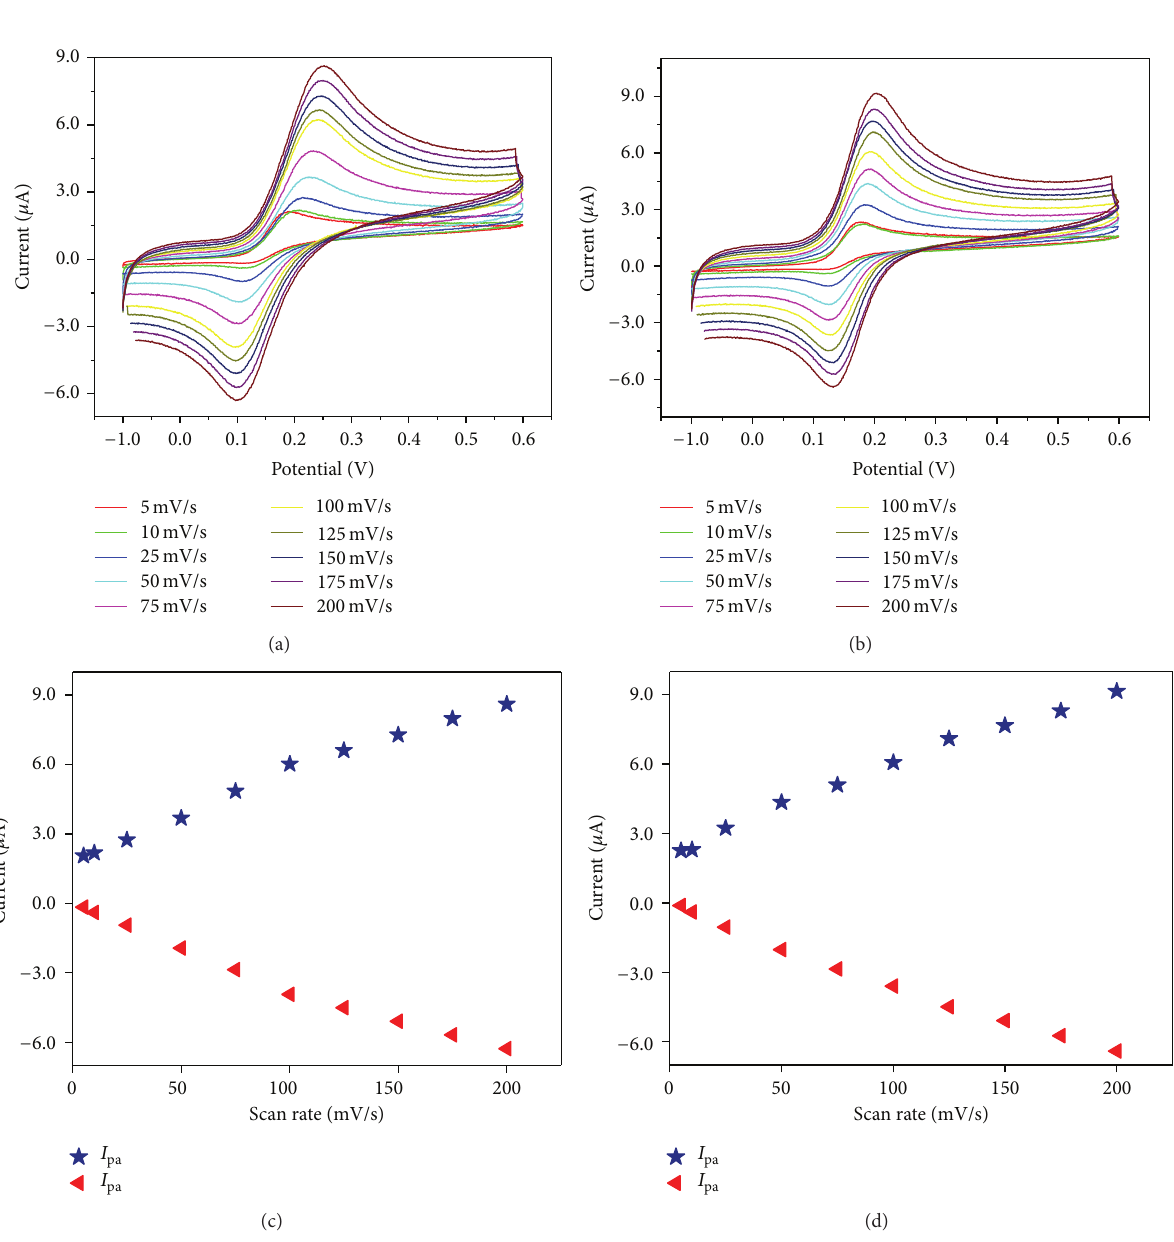
Figure 10: Cyclic voltammograms recorded for (a) bare GC and (b) 𝛼 -Fe 2 O 3 nanoparticle-modified electrode with 50 𝜇 M of DA in 0.1M PBS (pH = 6.8) at different scan rates: 5–200 mVs −1 . The plots of the peak current versus scan rate 1/2 obtained for the (c) bare GC and (d) 𝛼 -Fe 2 O 3 nanoparticle-modified